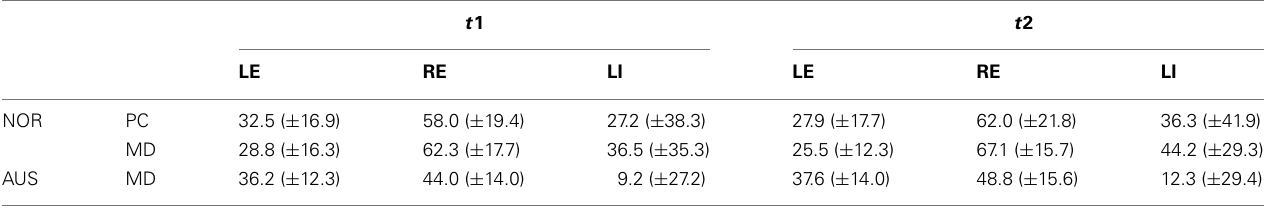
TableA1 | Correct report (mean ± standard deviation) for each sample, test version, and